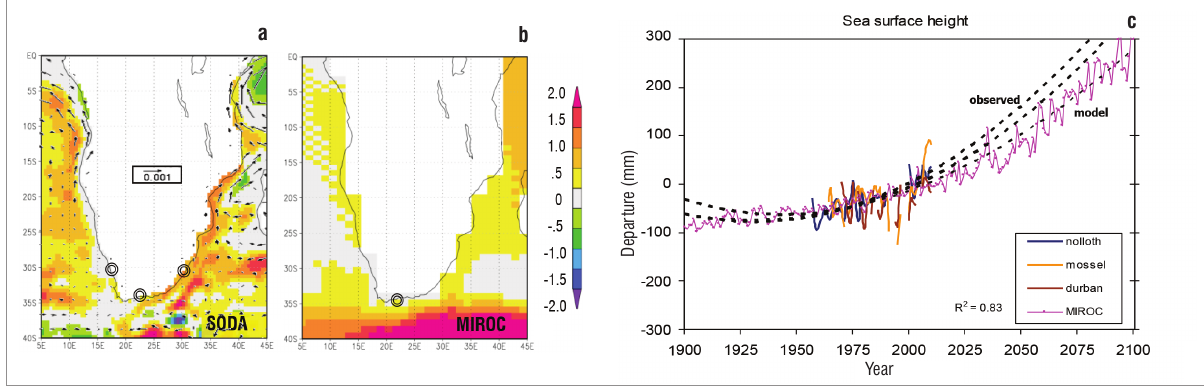
Figure 7: (a) Linear trend of sea surface height (mm/year) and upper ocean currents (m/s per year) in SODA reanalysis for 1958–2005. (b) MIROC A1B simulation of sea surface height trend (mm/year) for 1950–2050. (c) Intercomparison of gauge and model sea surface height at key points indicated by the circles in (a and